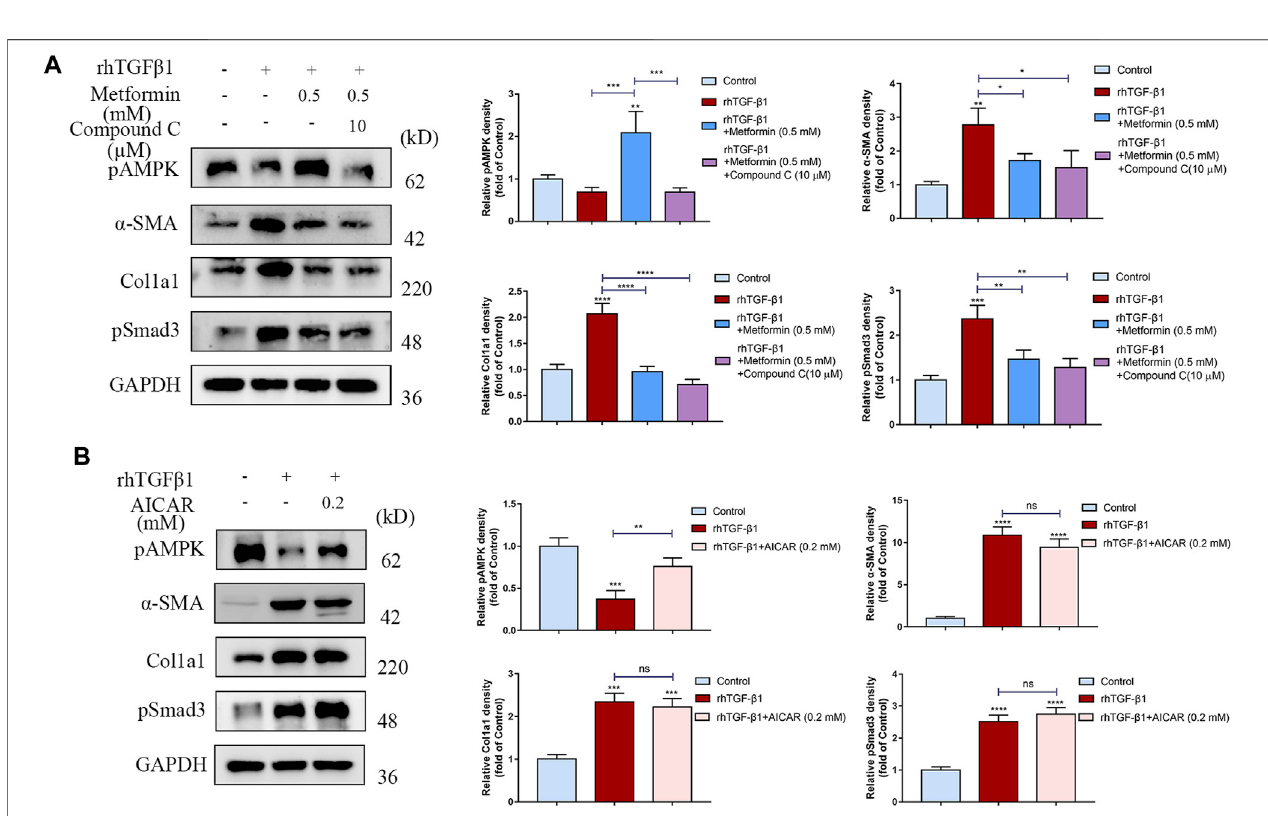
FIGURE 7 | The anti- fi brotic effects of metformin are independent of AMPK. (A) Compound C, an AMPK inhibitor, does not reverse the anti- fi brotic effects of metformin. Relative density values are calculated beside the blots. (B) Another AMPK activator, AICAR (0.2 mM), does not suppress the cell activation and collagen synthesis stimulated by TGF- β 1. Relative density values are shown beside the